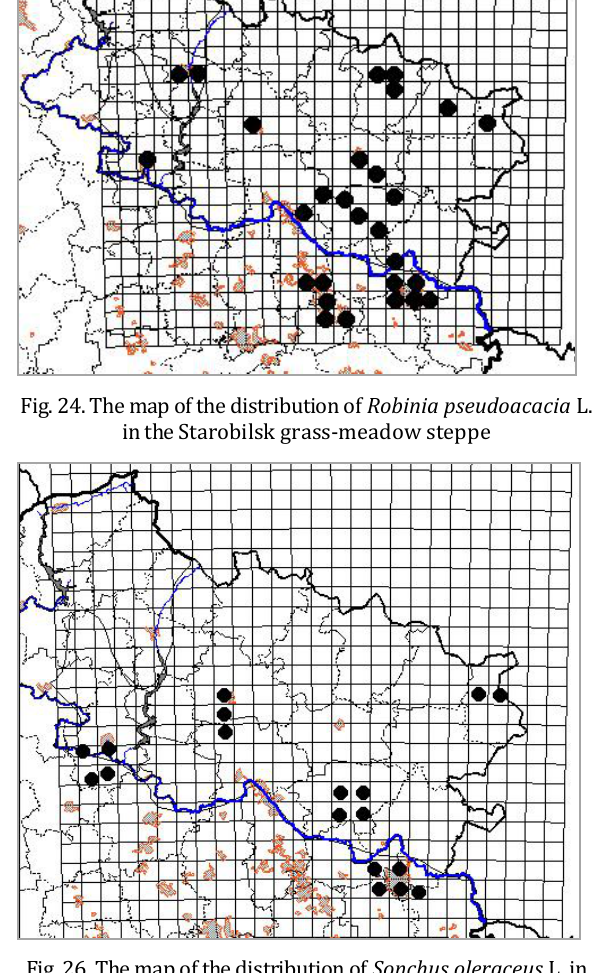
Fig. 26. The map of the distribution of Sonchus oleraceus L. in the Starobilsk grass-meadow steppe